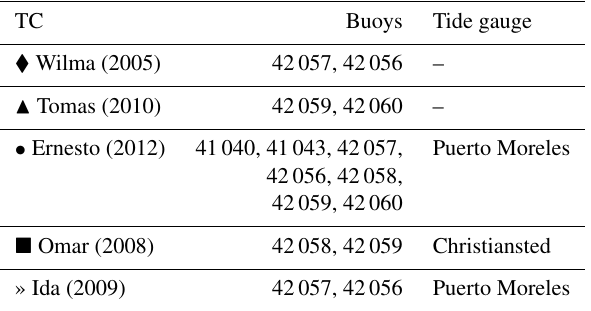
Table 1. List of the TCs used for the validation along with their respective buoys and tide gauges used in the